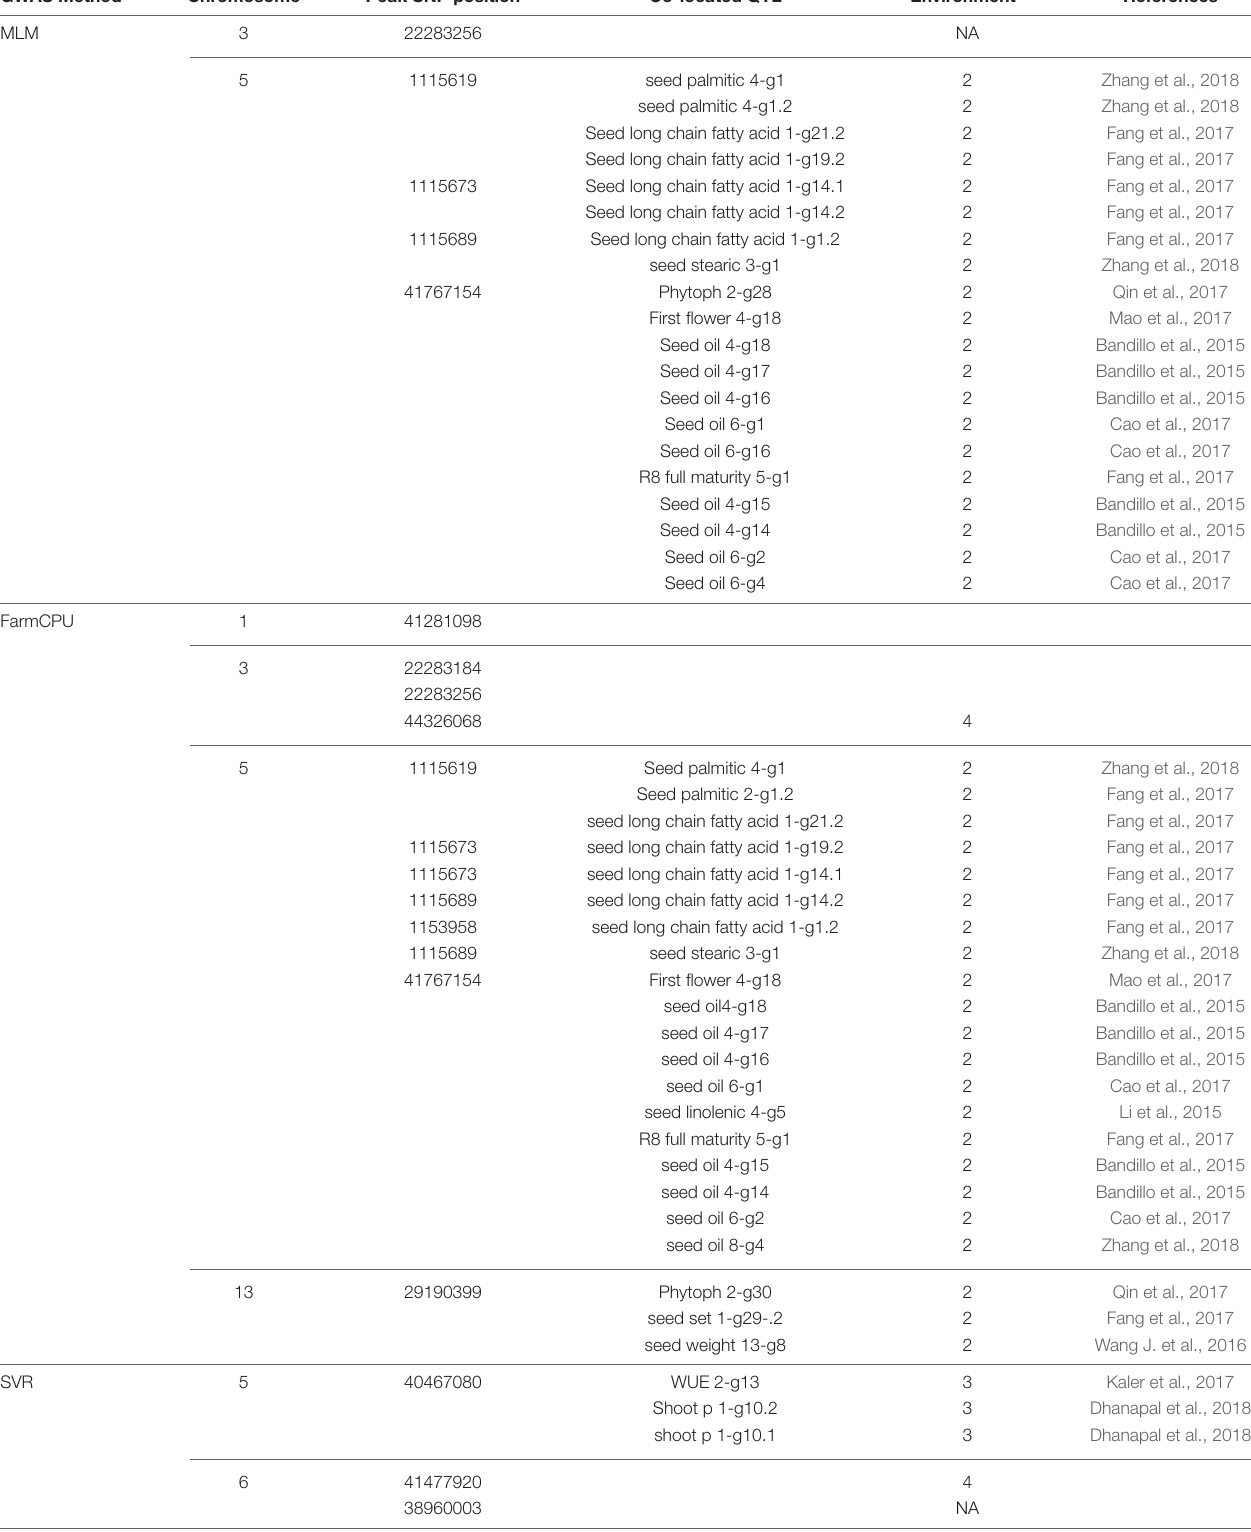
TABLE 2 | The list of detected QTLs for 550 nm using different GWAS methods in the tested soybean panel. GWAS